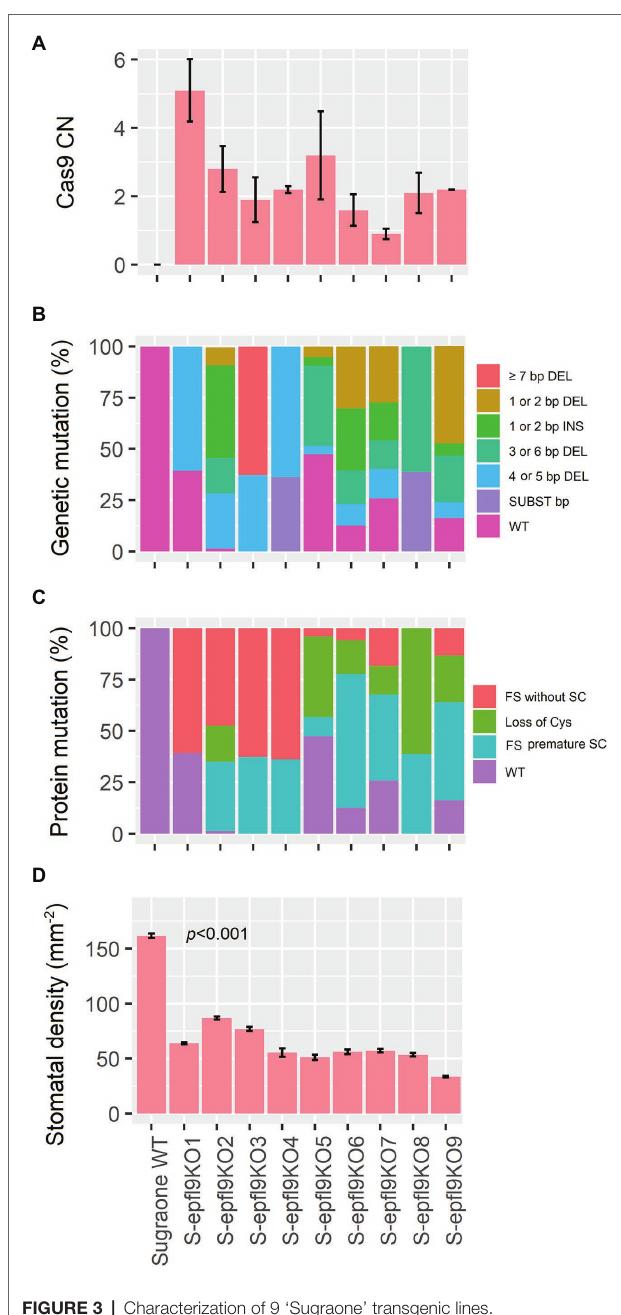
FIGURE 3 | Characterization of 9 ‘Sugraone’ transgenic lines. (A) Quantification of SpCas9 copy numbers (CN) integrated in the plant genome. CN were calculated by Real-time PCR as the mean value of two measurements obtained for two in-vitro biological replicates (except for line S- epfl9 KO9 for which only one value is available). (B) Bar plot indicating the mutation profile in the genomic target site on exon 3 of VvEPF9-1 after CRISPR/Cas9 editing. The mutation pattern and rate (%) of a specific mutation (IN/DEL, insertion/deletion and SUB, substitution) were determined by the number of reads calculated by Illumina sequencing (see Supplementary Table 4 ). Different kinds of mutations are indicated with a different color. WT = the wild-type sequence. (C) Bar plot indicating the resulting mutation profile in the functional mature VvEPF9-1 peptide, predicted according to the nucleotide mutations in B (see Supplementary Table 4 ). The different outcomes at protein level are indicated with a